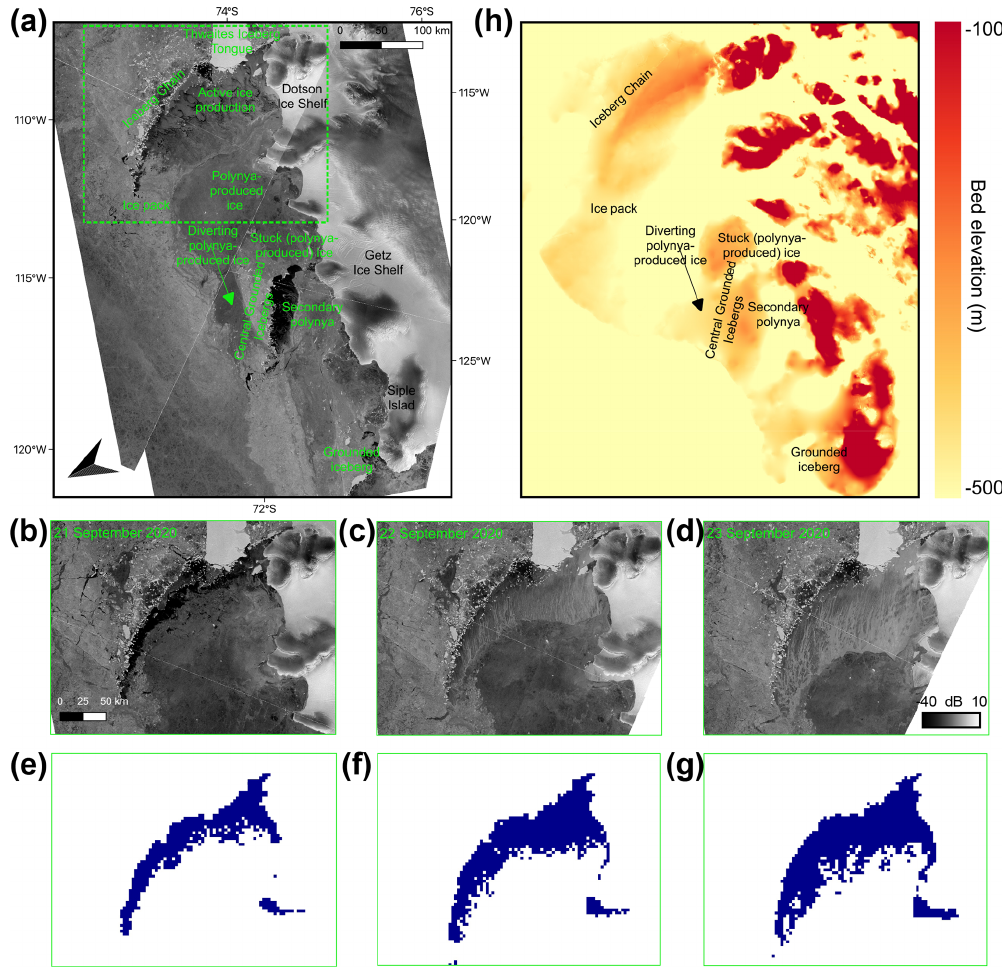
Figure 2. An example image of the ASP during the winter in a Sentinel-1 SAR image from 5 September 2019. (b–d) An example of an active polynya event taking place on 21–23 September 2020 in Sentinel-1 SAR imagery. Darker ice produced by the ASP can be seen diverting around the Central Grounded Icebergs (and some fast pack ice) after ice became stuck and obstructed outflow along the coast. The area corresponds to the dashed green box in panel (a) . (e–g) Active polynya area (blue) for the same dates and areas as panels (b) – (d) , as measured by using a 70% threshold with SIC data. (h) The elevation of the bed referenced to mean sea level for the same area as panel (a) . The bathymetry data are from the MEaSUREs BedMachine version 2 dataset (Morlighem,